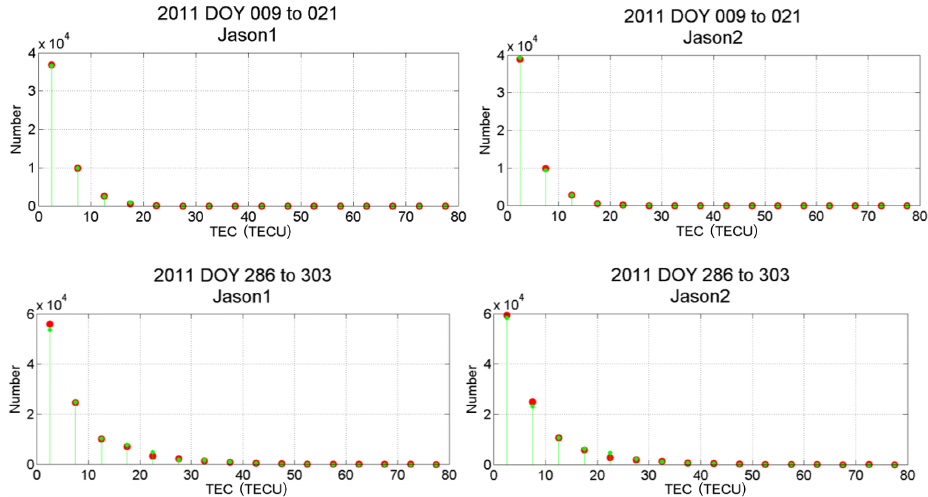
Figure 10. Histogram of the vTEC absolute residuals for Jason 1 (left) and 2 (right) satellites during the quiet (top) and disturbed (bottom)